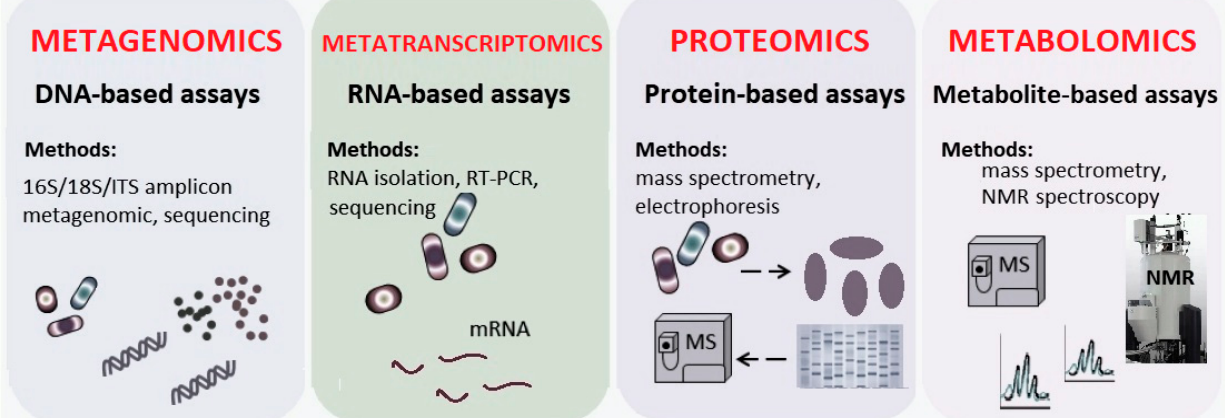
Figure 2. Representation of molecular approaches for modern studies host–microbiome interactions. Several aspects of the Central Dogma of Molecular Biology —illustrating the flow of genetic information from DNA to mRNA to protein—can be assessed to study host–microorganism and microorganism–microorganism interactions at the molecular level in human populations (adapted after [6,18,19]). Legend: mRNA: messenger ribonucleic acids, ITS: Internal Transcribed Spacer, RT-PCR: Reverse Transcription—Polymerase Chain Reaction, MS: mass spectrometry, NMR spectroscopy: Nuclear Magnetic Resonance spectroscopy.